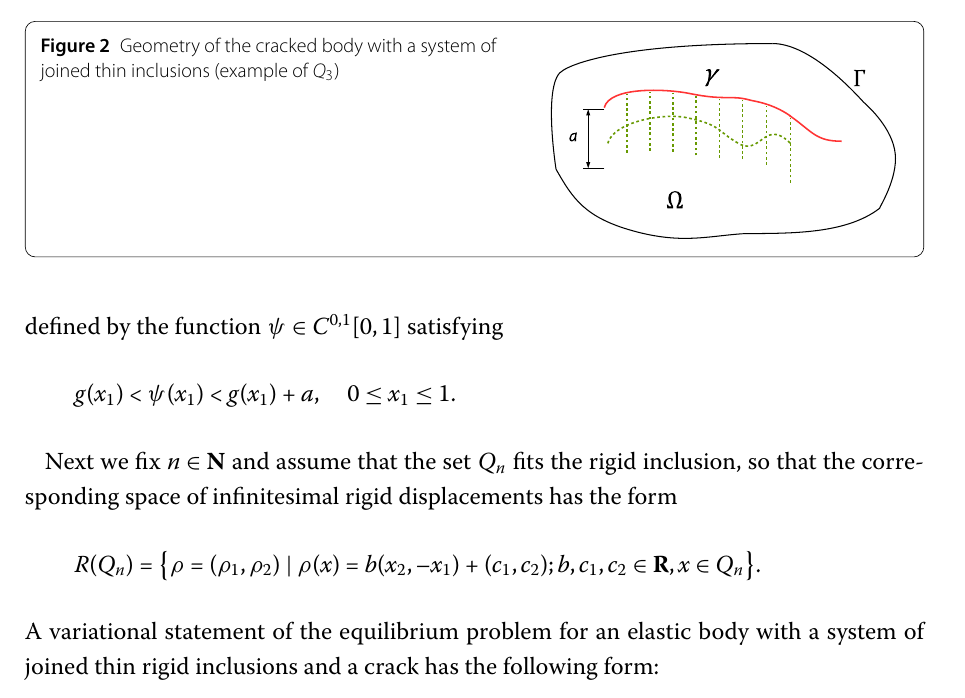
Figure 2 Geometry of the cracked body with a system of joined thin inclusions (example of Q 3 )